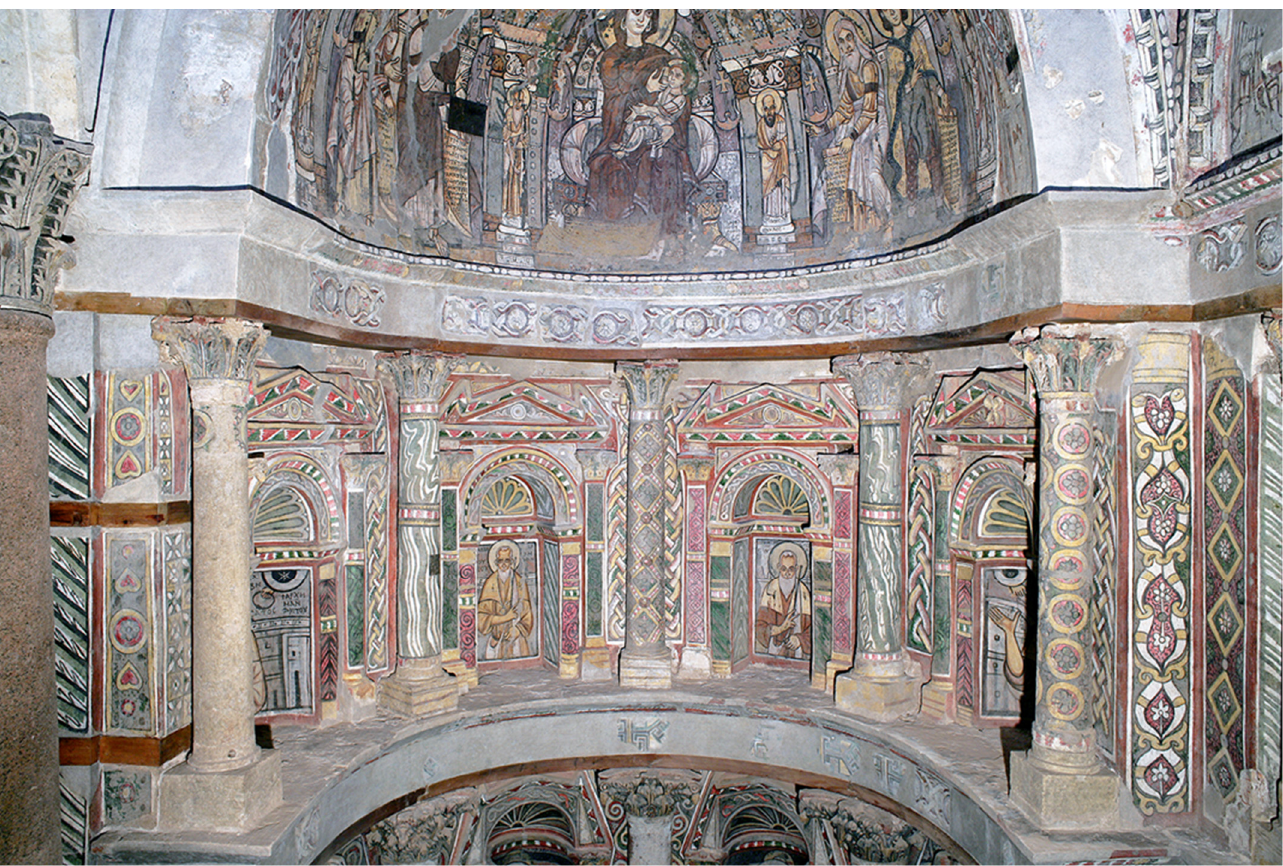
Figure 22. Interior of the Red Monastery Church, Sohag, Egypt, northern lobe of the triconch, detail of second register, paintings dated c. 6th century CE. This project was funded by the United States Agency for International Development (USAID). Photo: Arnaldo Vescovo.